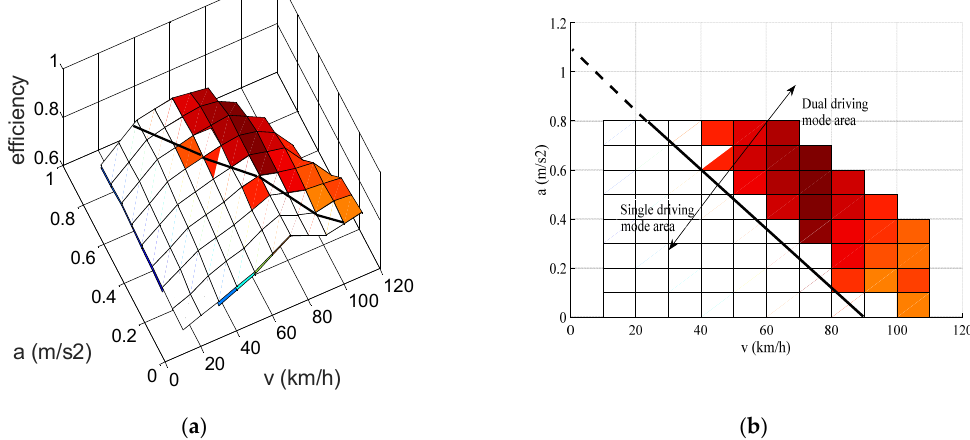
Figure 7. Efficiency comparison and switching rule under Condition 1. ( a ) Efficiency comparison under Condition 1; ( b ) Switching rule under Condition